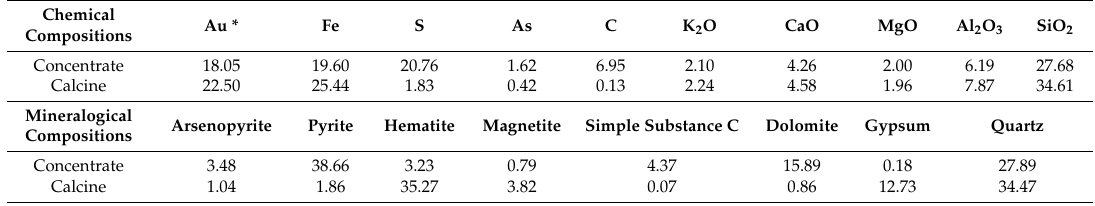
Table 1. Chemical and mineralogical compositions of gold concentrate and calcine samples/(mass fraction, %).